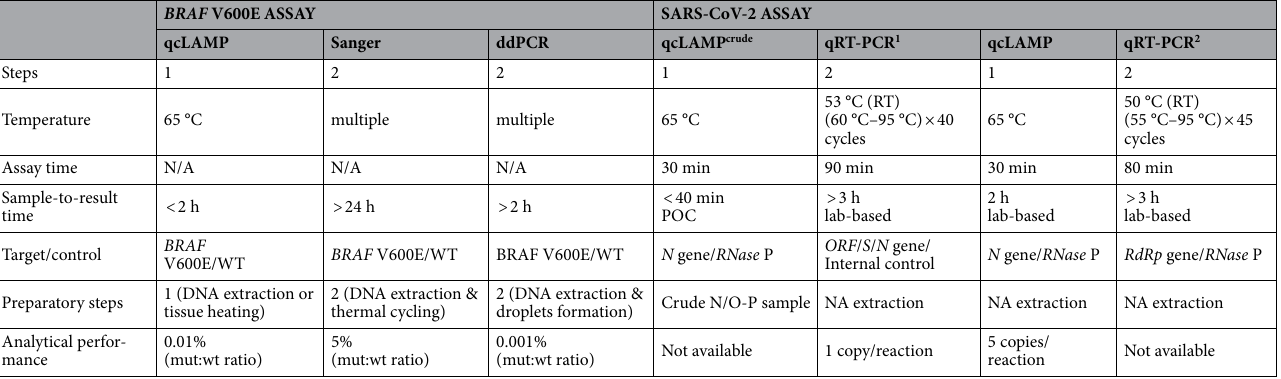
Table 1. Comparison of the qcLAMP, Sanger sequencing, ddPCR and qRT-PCR methods for the two applications. PCR 1 and PCR 2 refer to the different protocols used in the two validation sites (Lab. of Clinical Virology and Hellenic Pasteur Institute,